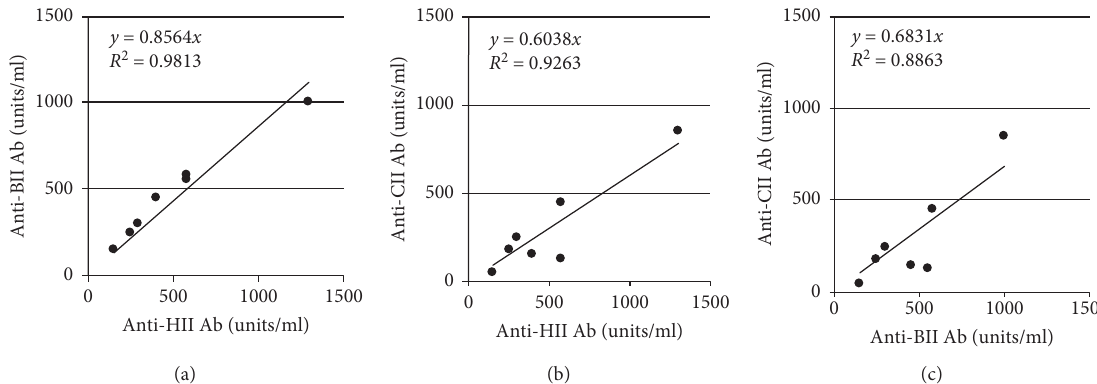
Figure 1: Specificity of anti-type II collagen antibodies in RA patients. Cross-reactivity of autoantibodies (Ab), purified from RA patient serum using an HII-affinity column: bovine type II collagen (BII), chick type II collagen (CII), and human type II collagen (HII). (a) HII versus BII. (b) HII versus CII. (c) HII versus CII.